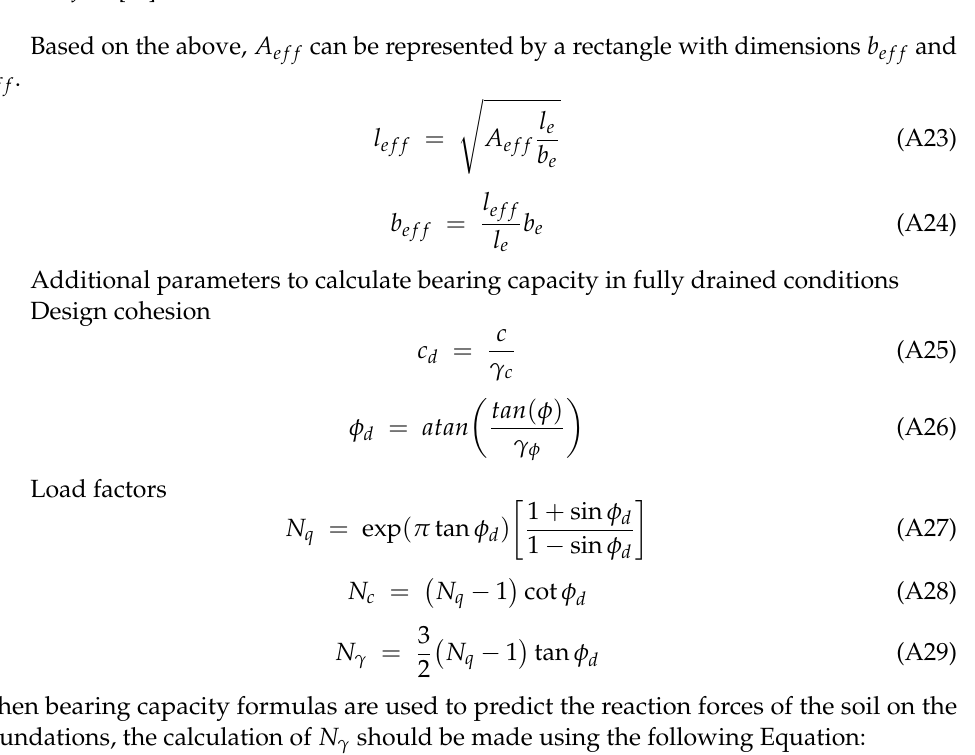
Figure A3. Circular and octangular footings with the effective foundation area marked out, based on DNV ‐ OS ‐ J101 [15].